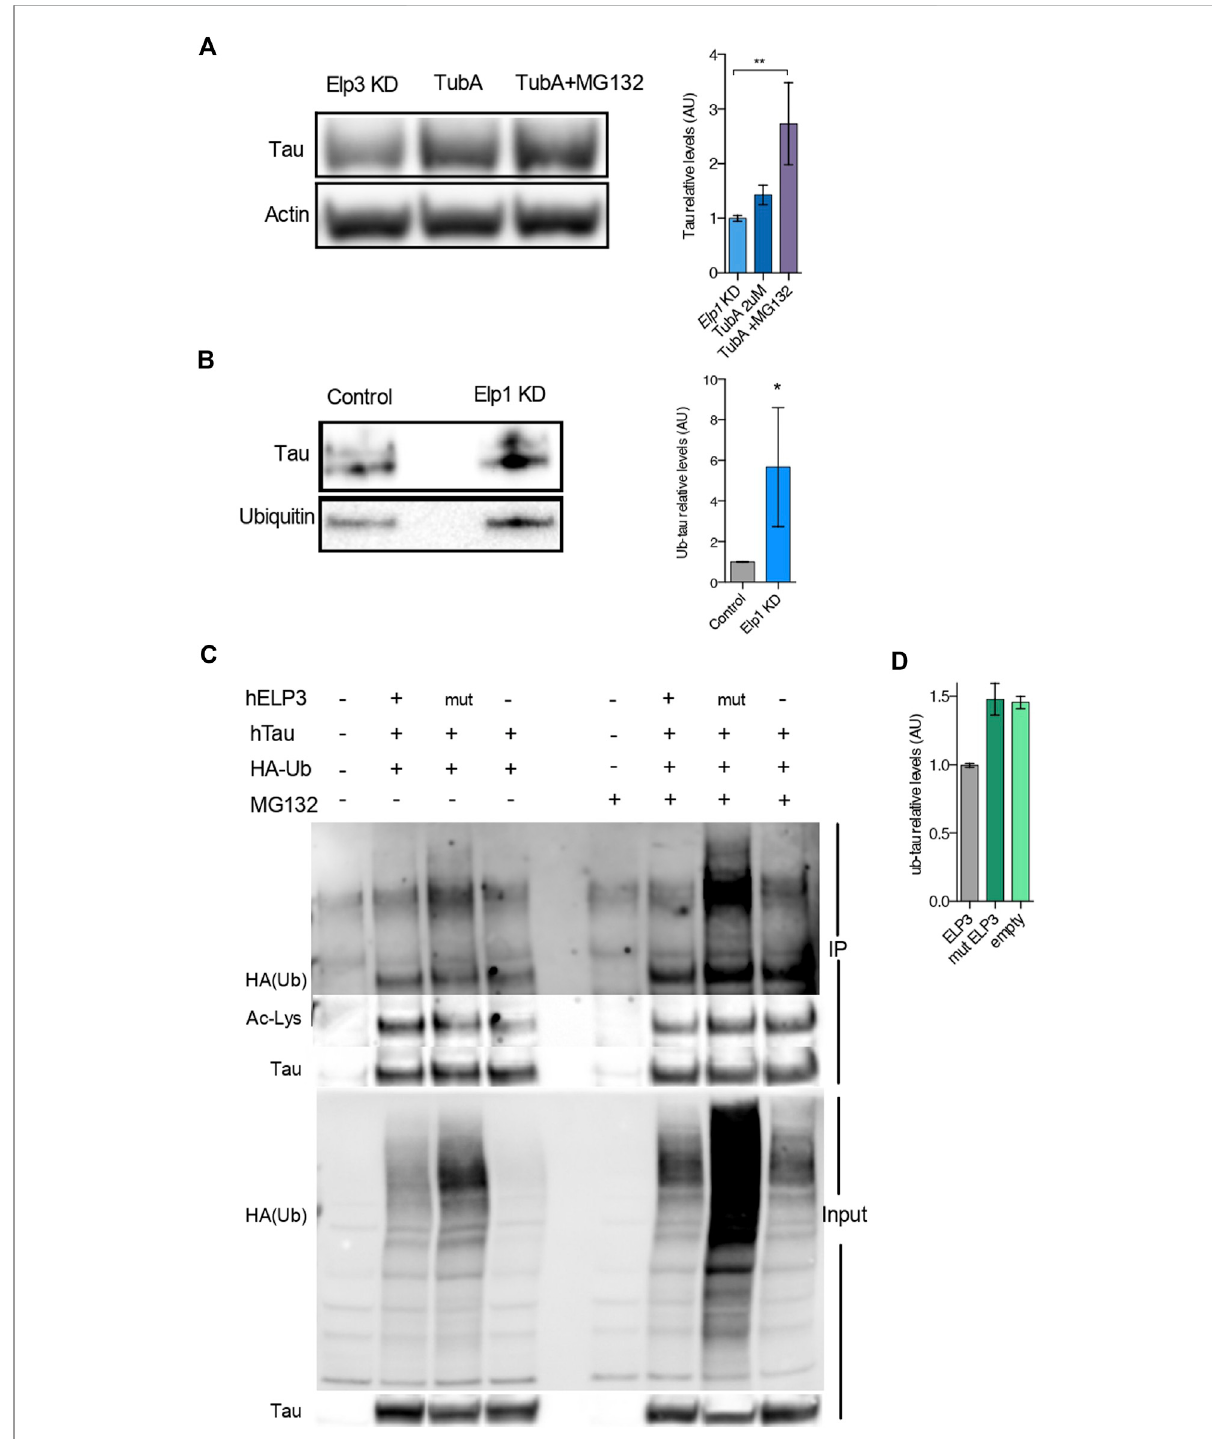
FIGURE 6 ElongatorDe fi ciencyReducesTauacetylation,IncreasesTauubiquitylationandinducesitsDegradation. (A) Immunoblottingandquanti fi cation of Tau and ß-Actin in differentiated SHSY5Y extracts from Control and Elp1 KD cells incubated with vehicle, Tubastatin A (TubA, 2 µM) for 24 h or Tubastatin A (TubA, 2 µM) for 24 h together with MG-132 (MG132 , 20 µM) for the last 4 h. (B) Immunoprecipitation followed by Western blotting to detect and quantify ubiquitylated Tau, in control and Elp1KD cells extracts. Histograms of proportion of ubiquitin expression to Tau. (C – D) Immunoprecipitation of Tau followed by Western blotting to detect and quantify ubiquitylated Tau; Lysates from HEK293 cells transfected with plasmids expressing WT Tau, HA-tagged ubiquitin and ELP3 or mutated ELP3 in the KAT domain or empty vector incubated with vehicle or MG-132